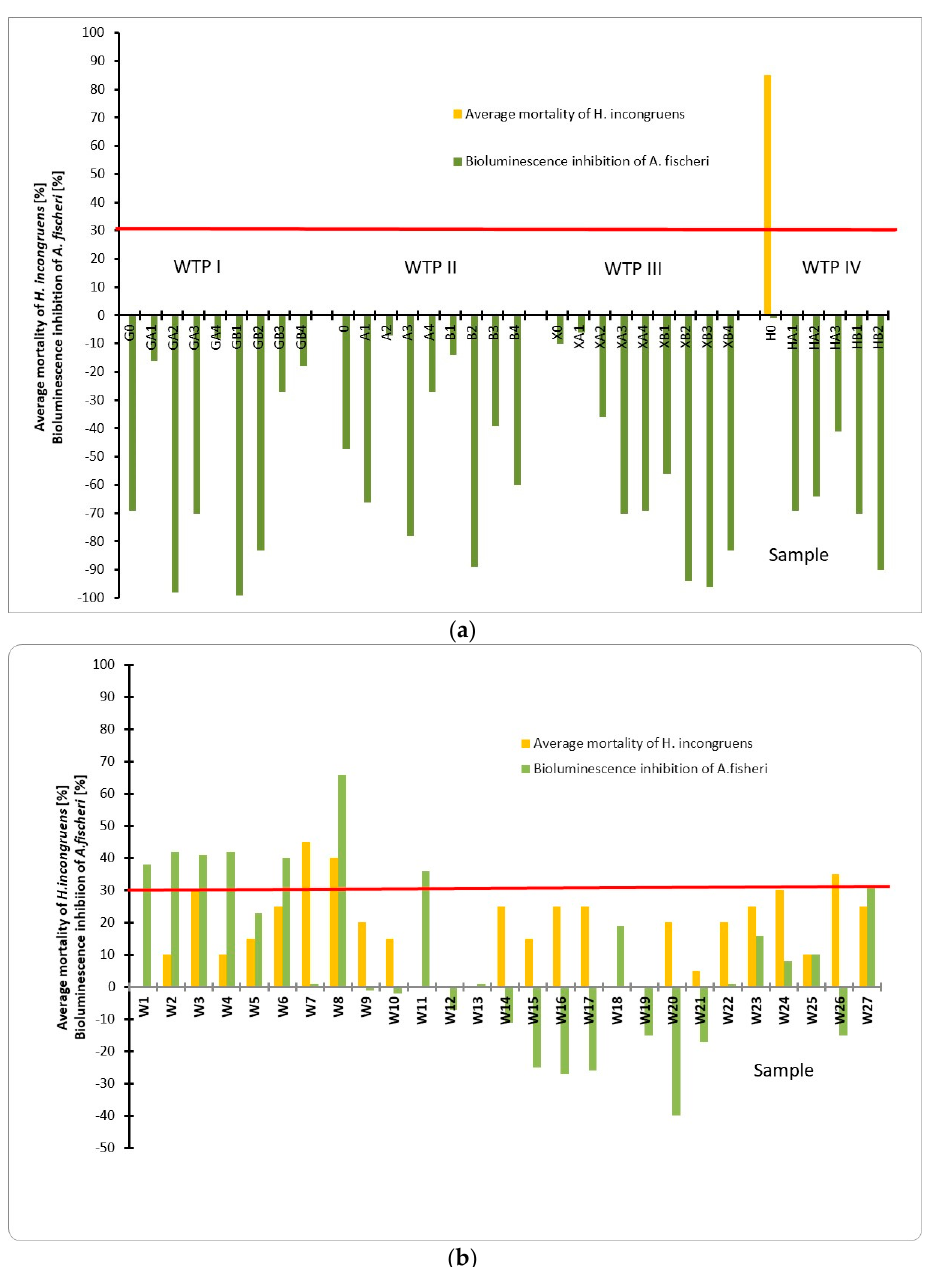
Figure 1. Toxicity of bottom sediments taken around the sewage collectors’ outlets from wastewater treatment plants (WTP I-WTP IV) ( a ) and from the mouth of Vistula ( b ) (samples below the red line have mortality of H. incongruens less than 30% and growth inhibition data related to these cases is shown in Figure S1 of the Supplementary Materials).